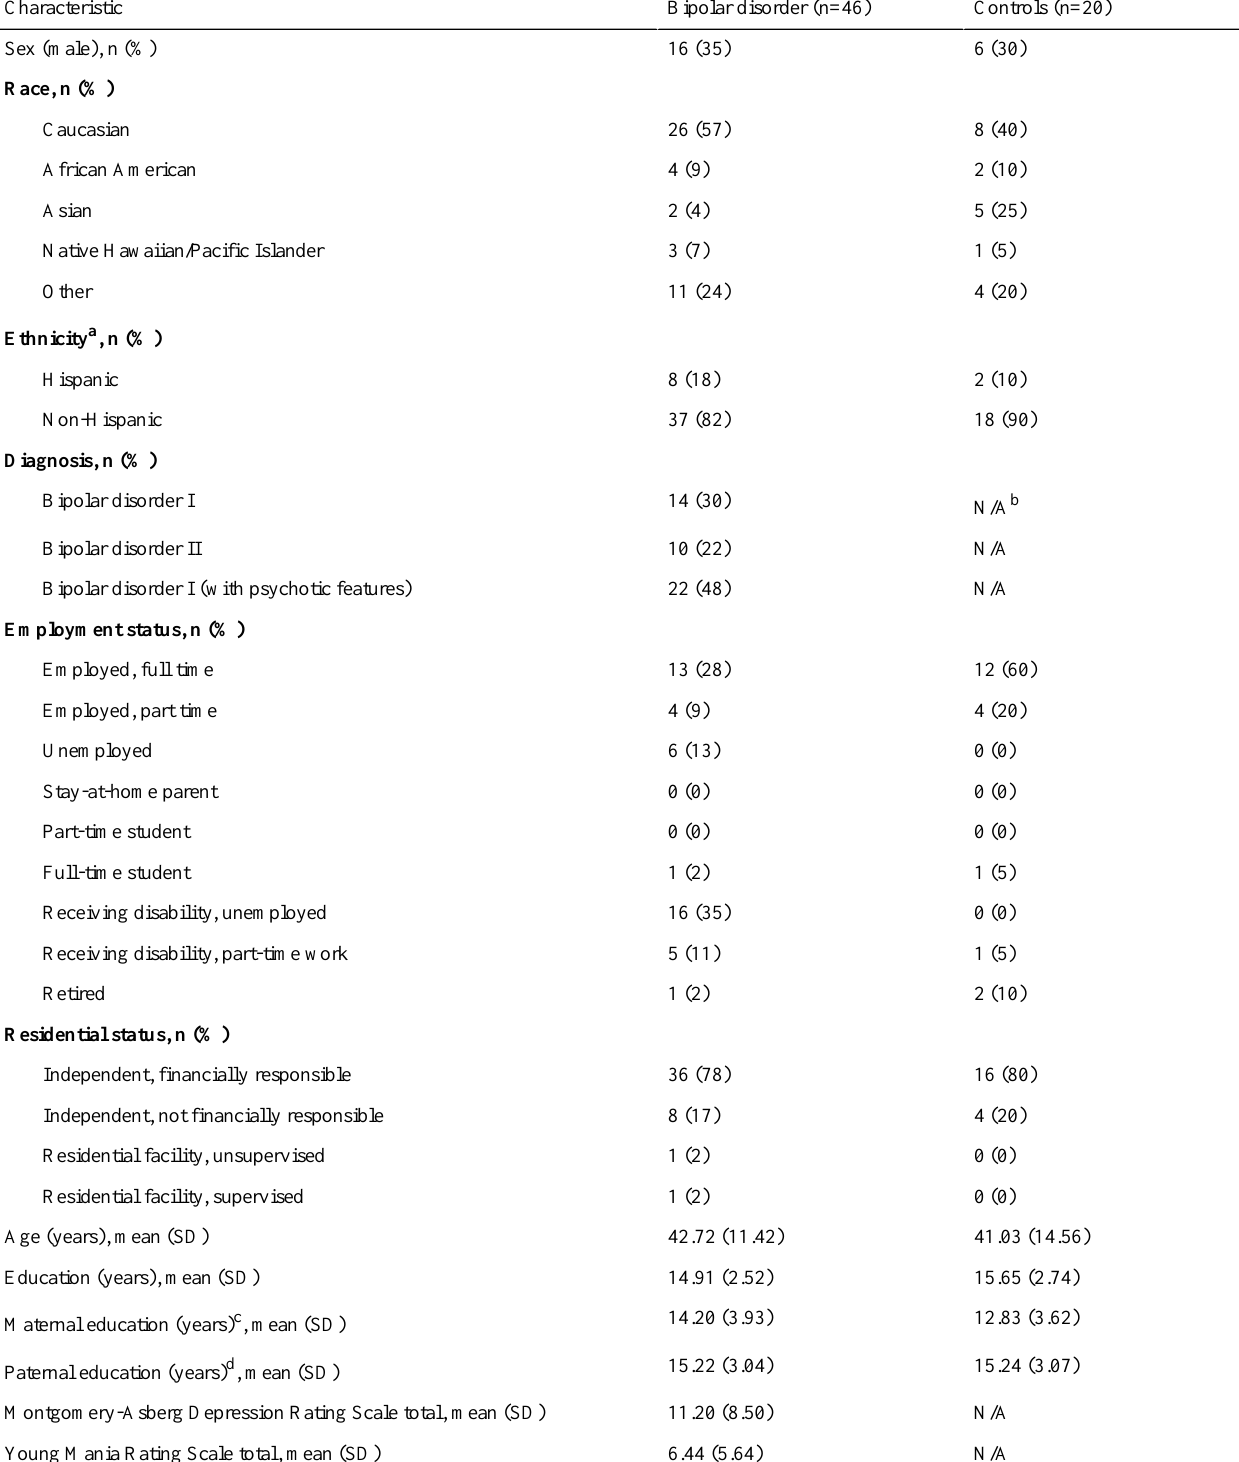
Table 3. Participant demographic and clinical characteristics for parent study